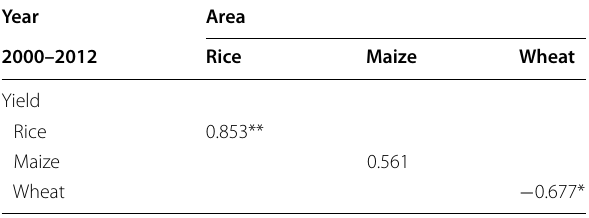
Table 4 Correlation matrix between fertilizer